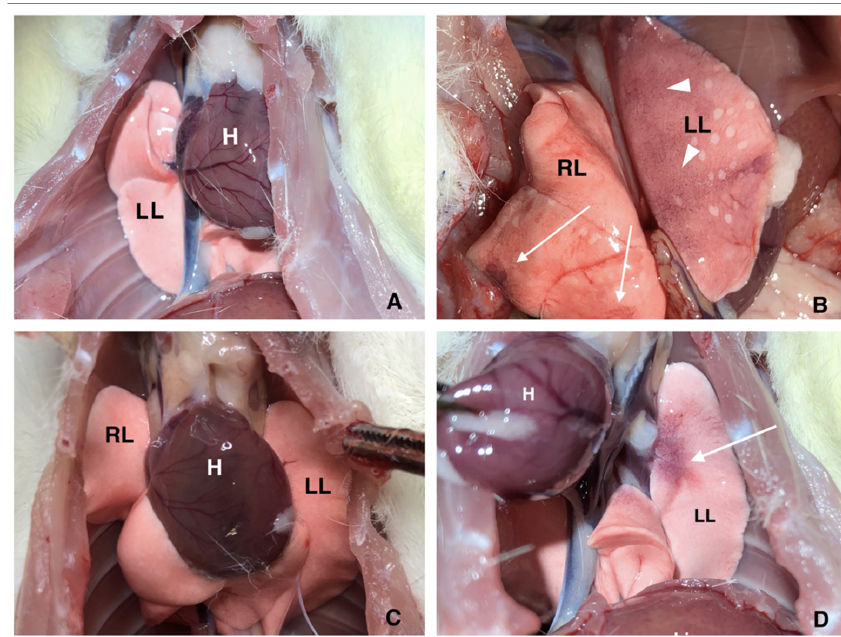
Figure 2. Macroscopic changes in the rat lungs: ( A ), normal intact rat lung without macroscopic changes. ( B ), diffuse (arrowheads) and local (arrows) sites of cyanosis; rat with normal neutrophil count after 48 h IVC ligation. ( C ), no signs of lung injury/malfunction in a neutropenic rat after 48 h IVC stenosis; ( D ), sporadic local site of cyanosis (arrow) near lung root in the sham-operated rat. RL, right lung; LL, left lung; H, heart. Representative images out of 10–15 experiments.